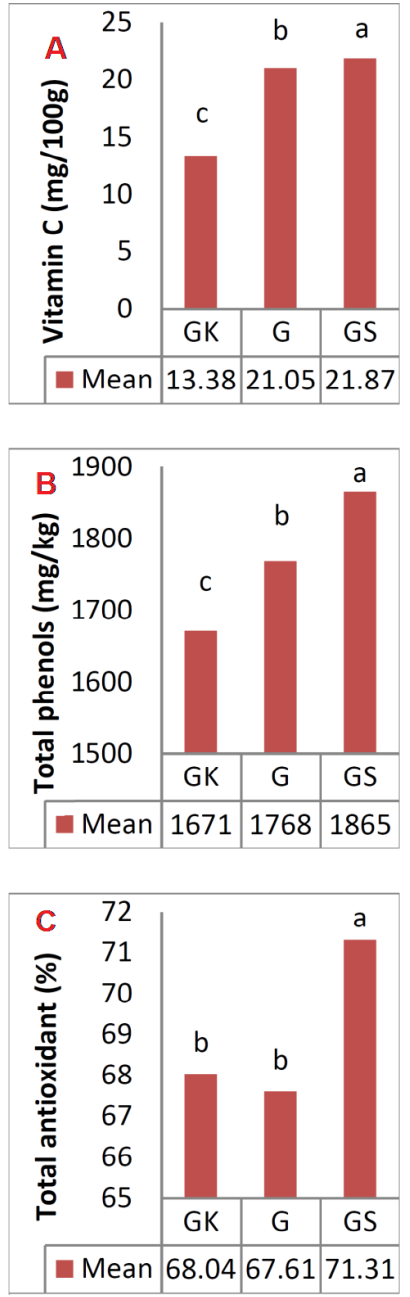
Figure 1. Effect of Cultivar on Vitamin